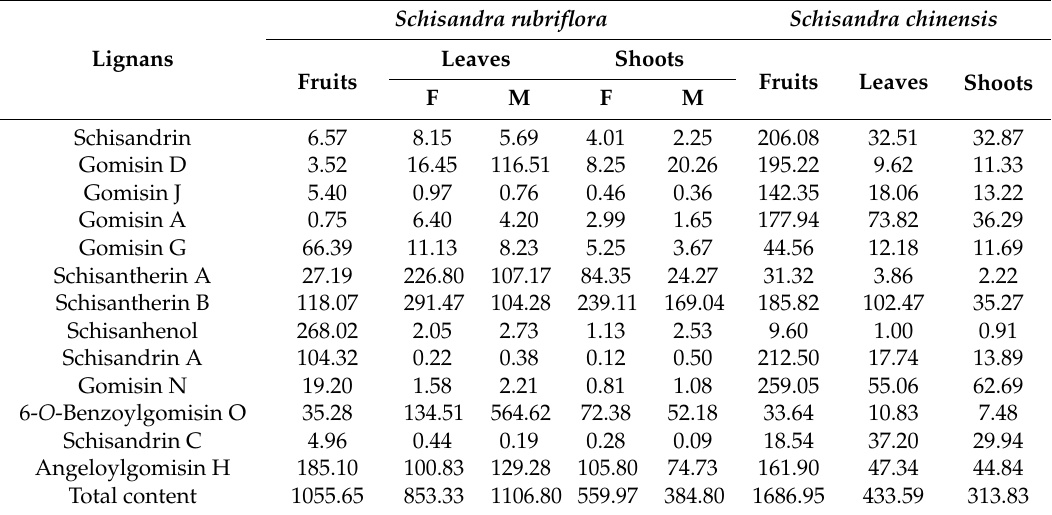
Table 5. The comparison of the amounts (mg/100g DW) of the dominant lignans in the studied S. rubriflora and S. chinensis